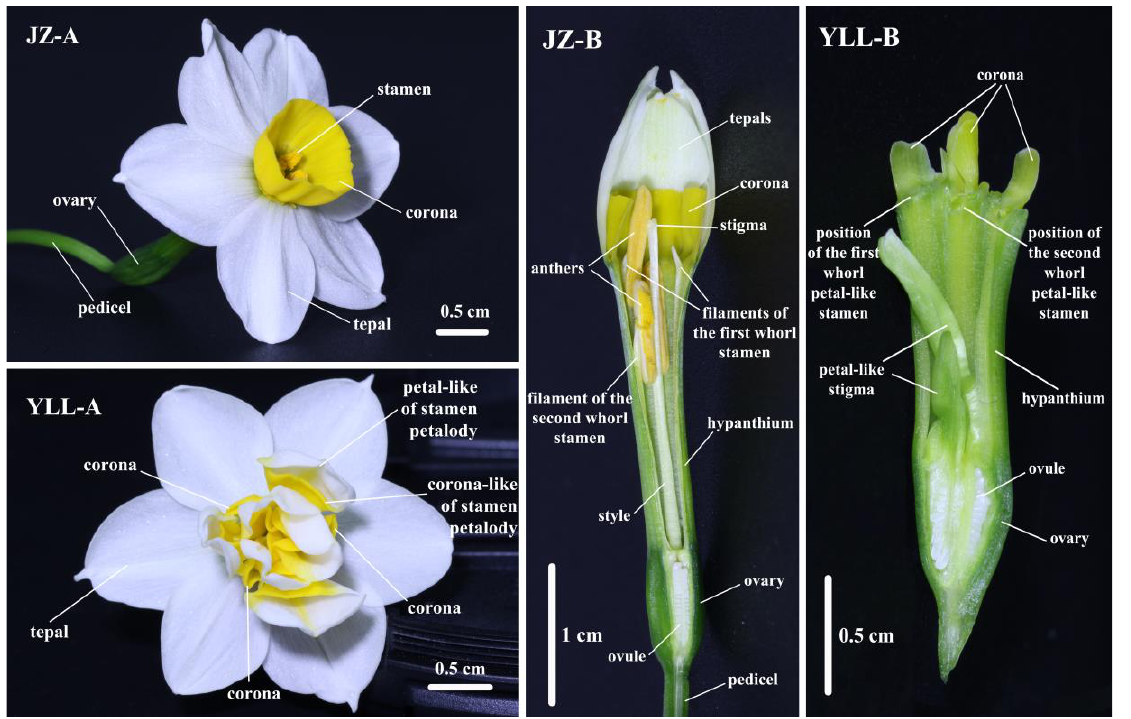
Figure 1. Flower types of JZ and YLL. JZ and YLL denote “Jinzhanyintai” and “Yulinglong”, respec- tively. A represents flower morphology at the full-bloom stage, and B represents the longitudinal section of